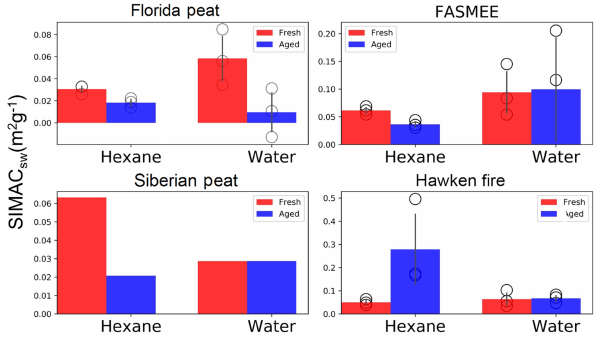
Figure 8. Comparison of the total solar-weighted spectrally inte- grated mass absorption coefficient (SIMAC sw , units: m 2 per gram of OC) for the fresh and aged aerosols in water and hexane extracts, normalized to 1mL extraction volumes. Bars, circles, and error bars represent the mean values, individual observations, and standard de- viations, respectively. No error bars are given for Siberian peat, be- cause only one experiment was performed with this fuel.